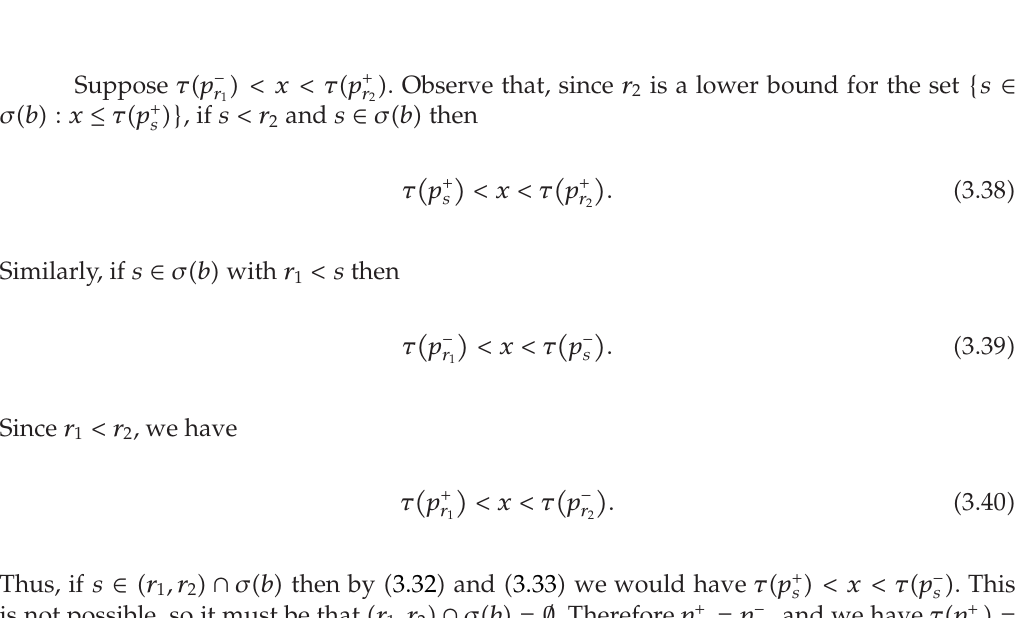
Figure 5: Ray in ∂ L B (cid:2) b (cid:3) \ B (cid:2) b (cid:3) —Theorem